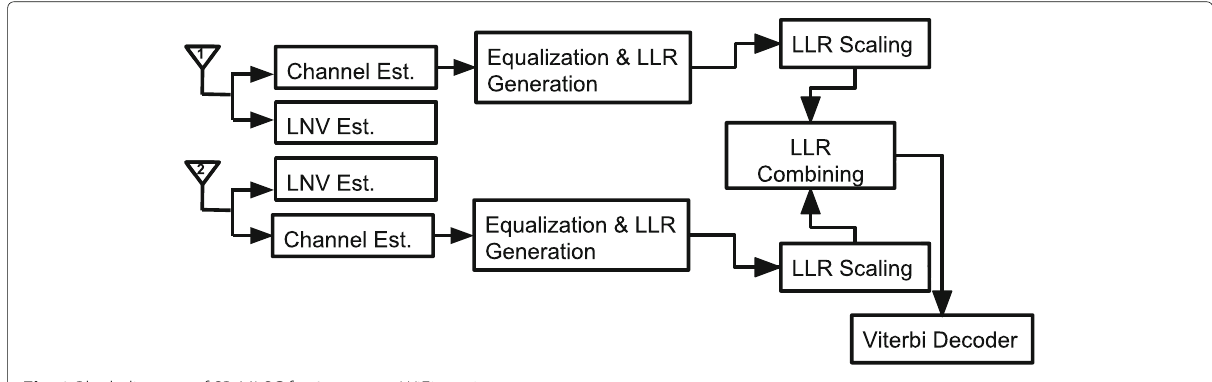
Fig. 9 Block diagram of SB-MLSC for 2-antenna WiFi